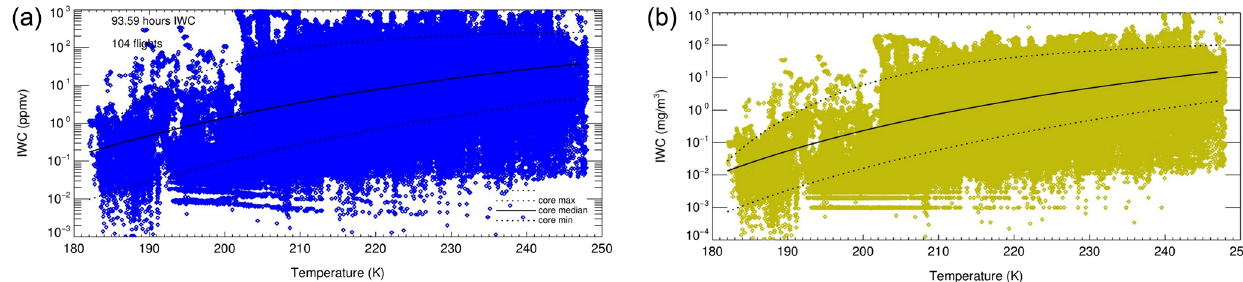
Figure 2. Observations of IWC vs. temperature during the flights shown in Fig. 1. (a) Mixing ratio, (b) concentration. Lines: median IWC (solid) and upper and lower bound of core IWC band (dotted) from observations of Schiller et al. (2008) and Luebke et al. (2013). Total flight distance in clouds was about 67.390km ≈ 336 . 960 data points (all data are sampled at 1Hz).